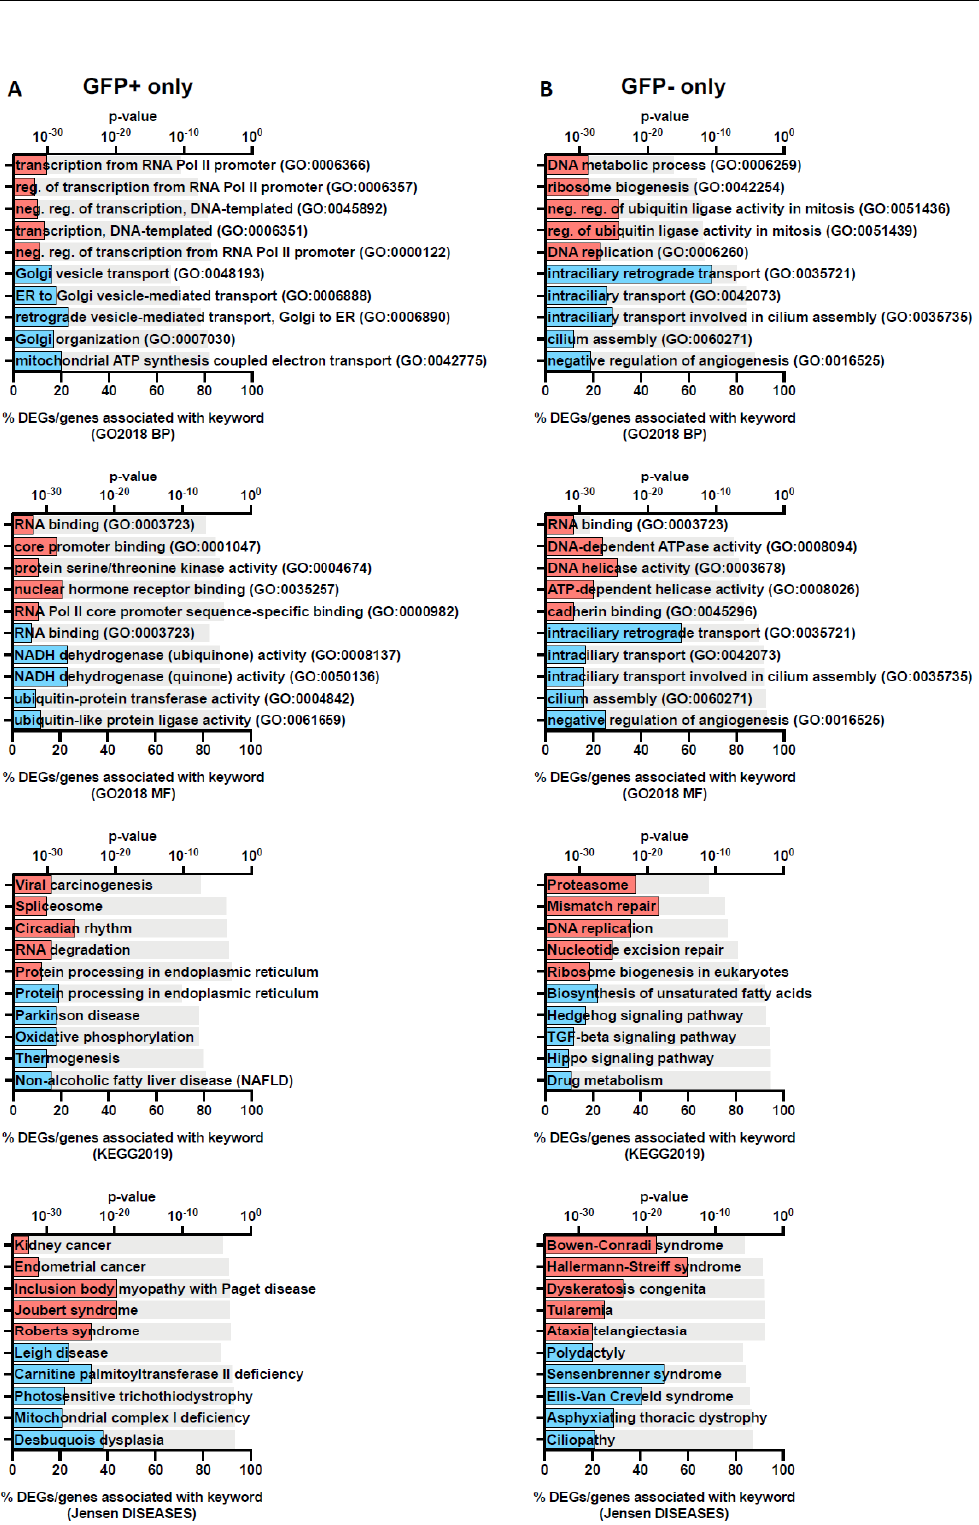
Figure 3. Gene set enrichment analysis of DEGs in GFP+ only and GFP − only populations showing unique genes identified in each population. The top 5 functional annotation gene-set associations for the two gene profiles: GFP+ ( A ) and GFP − ( B ) without overlap were identified using Enrichr with Gene Ontology Biological Process (GO2018 BP) and Molecular Function (GO2018 MF), KEGG and Jensen DISEASES databases. Keywords associated with up- and downregulated genes are coloured red and blue, respectively. The grey bar represents the p-values determined by the Enrichr analysis